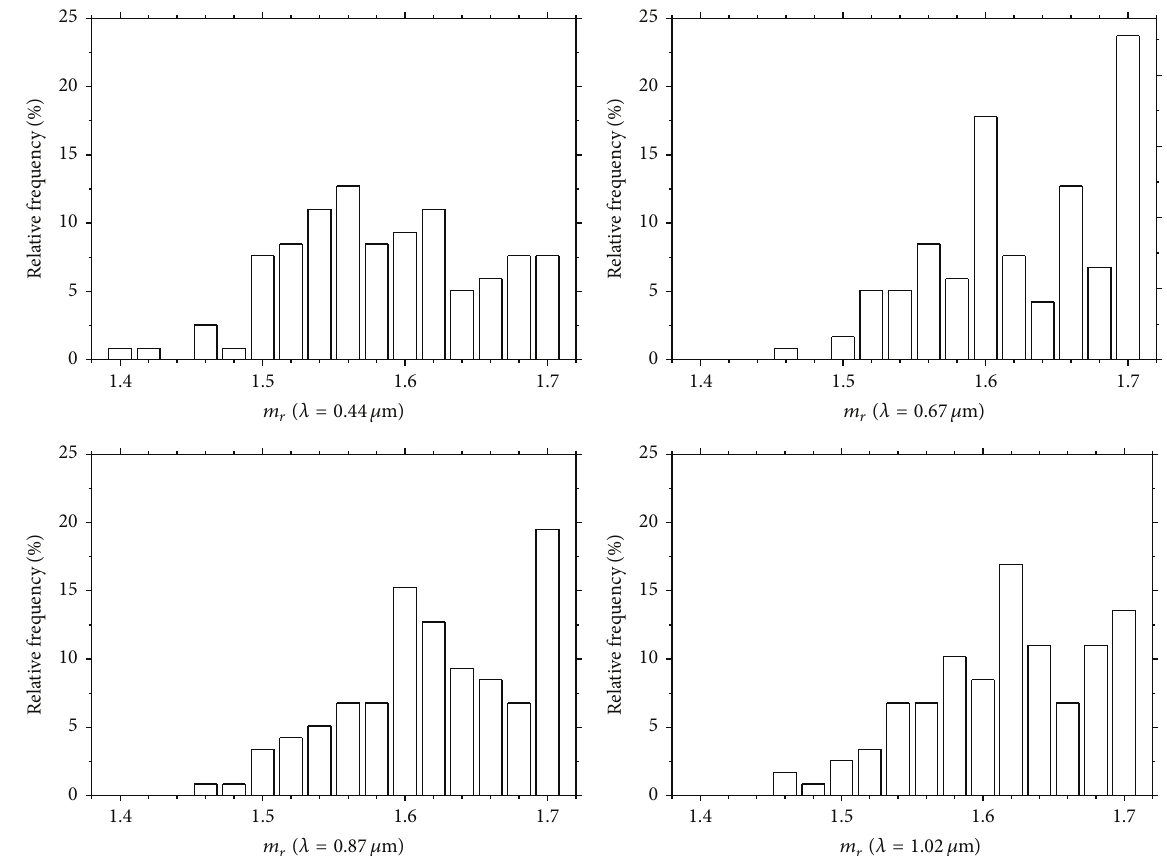
Figure 8: The histograms of the real part of complex refractive index for dust aerosol at 0.44, 0.67, 0.87, and 1.02 𝜇 m.